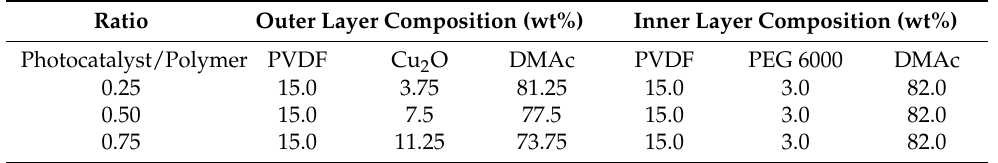
Table 1. Polymer dope solutions compositions. Ratio Outer Layer Composition (wt%) Inner Layer Composition